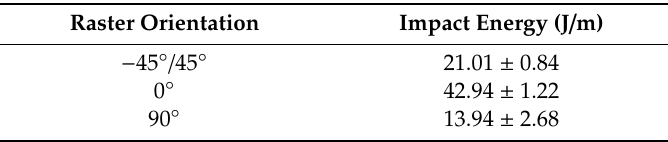
Table 5. Izod Impact Testing Results.